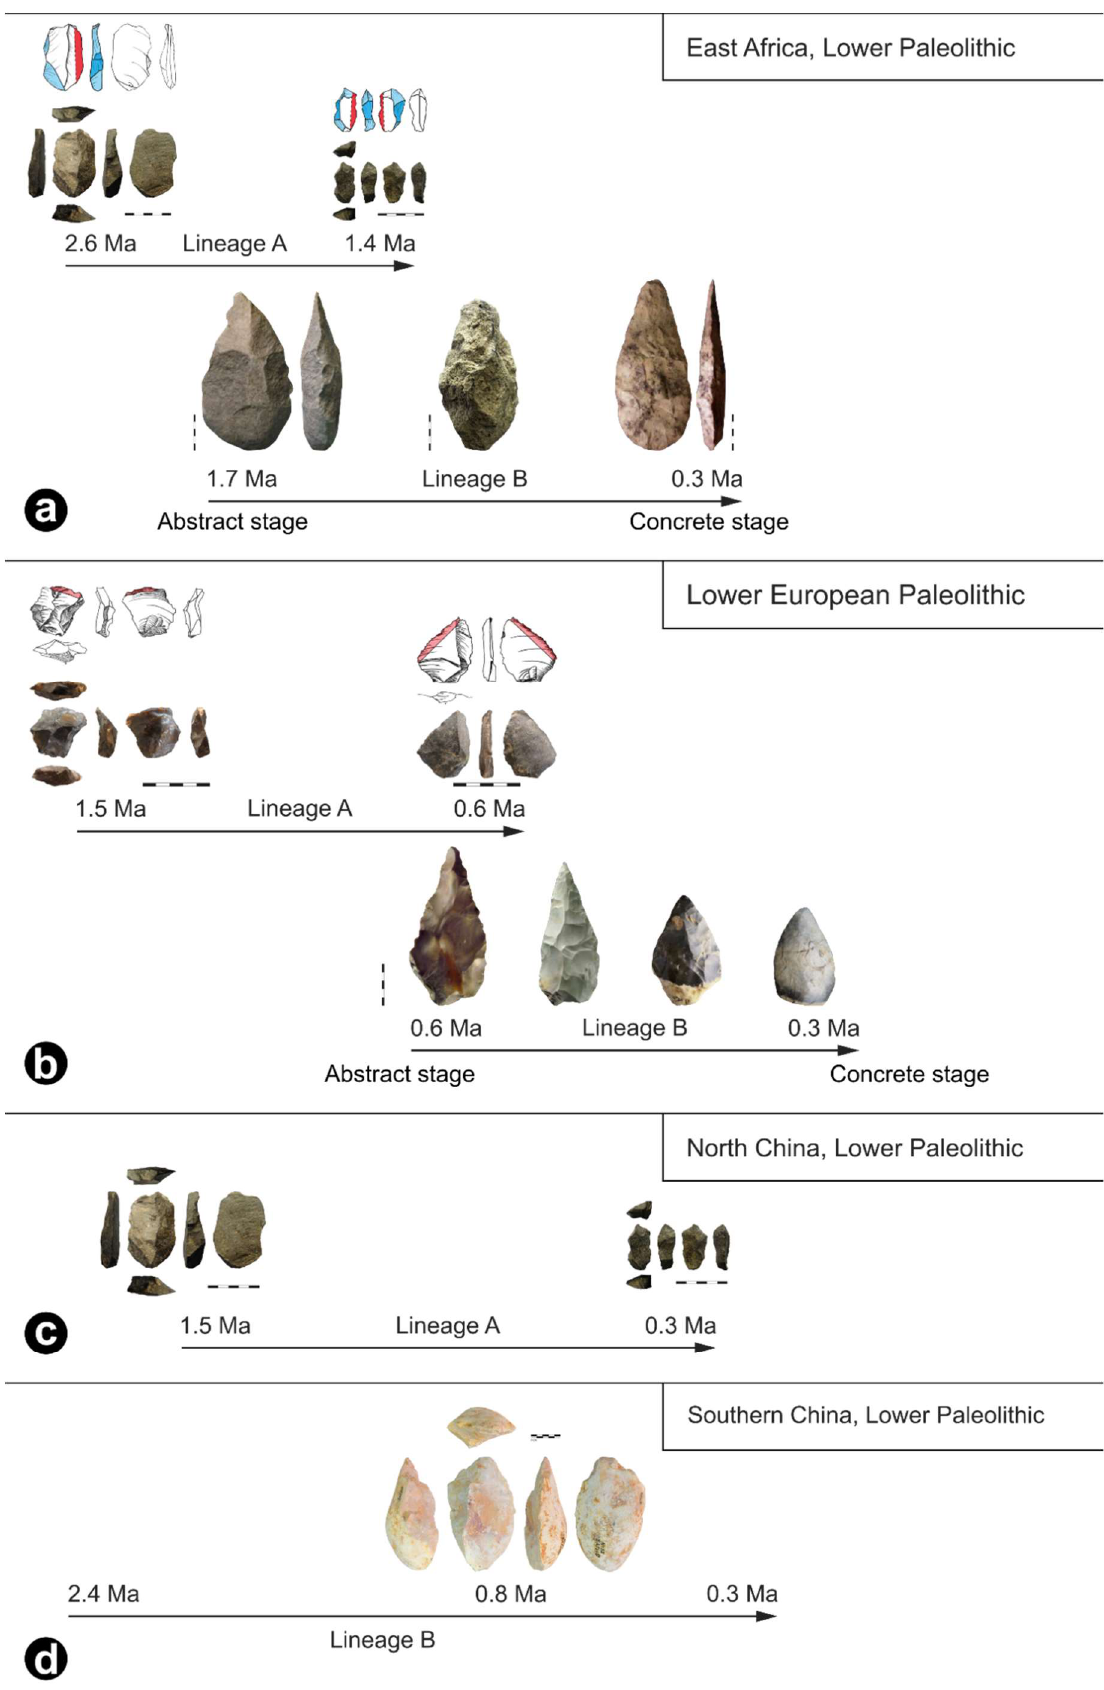
Figure 18. Examples of technical lineages in Africa (a), Europe (b) and Asia (c, d). (5 cm scale bars (1 cm